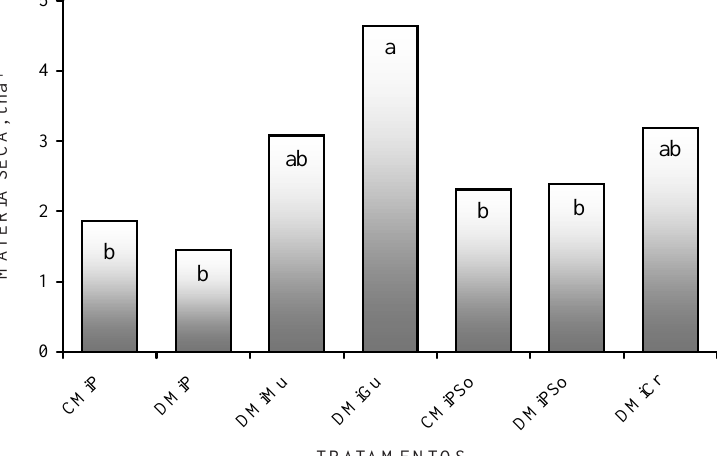
bba ab Figura 6. Valores de matéria seca produzida, durante o inverno de 1996, pelos adubos verdes e plantas daninhas em um Latossolo Roxo cultivado com diferentes sistemas de produção por seis anos consecutivos. Médias seguidas de mesma letra não diferem significativamente entre si. C = sistema de semeadura convencional; D = sistema de plantio direto; Mi = milho semeado no verão; So = soja semeada no verão; P = pousio no inverno; Mu = semeadura de mucuna-preta no inverno; Gu = semeadura de feijão guandu no inverno; Cr = semeadura de Crotalaria juncea no inverno.